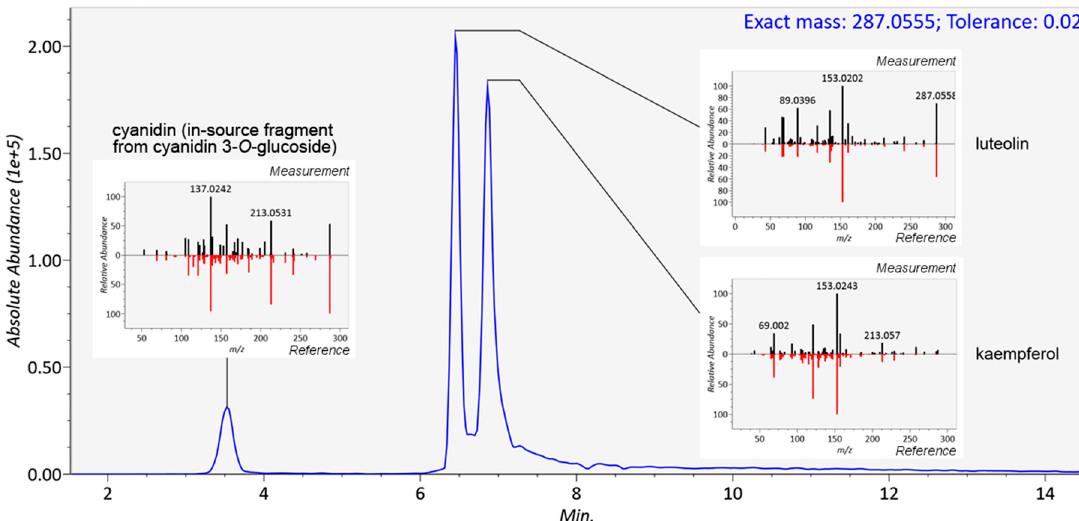
Figure 4. Separation and identification of three flavonoids, cyanidin, luteolin, and kaempferol, with the same molecular formula of the positive ion (C 15 H 11 O 6+ ) in platform 8. The compounds were identified based on their MS/MS spectra, which were compared with reference spectra from publicly available databases [35]. Based on the retention time of cyanidin 3- O- glucoside, also present in the mixture, the feature appearing at RT 1.77 min in platform 7 and 3.5 min in platform 8 was identified as an in-source fragment (cyanidin ion).